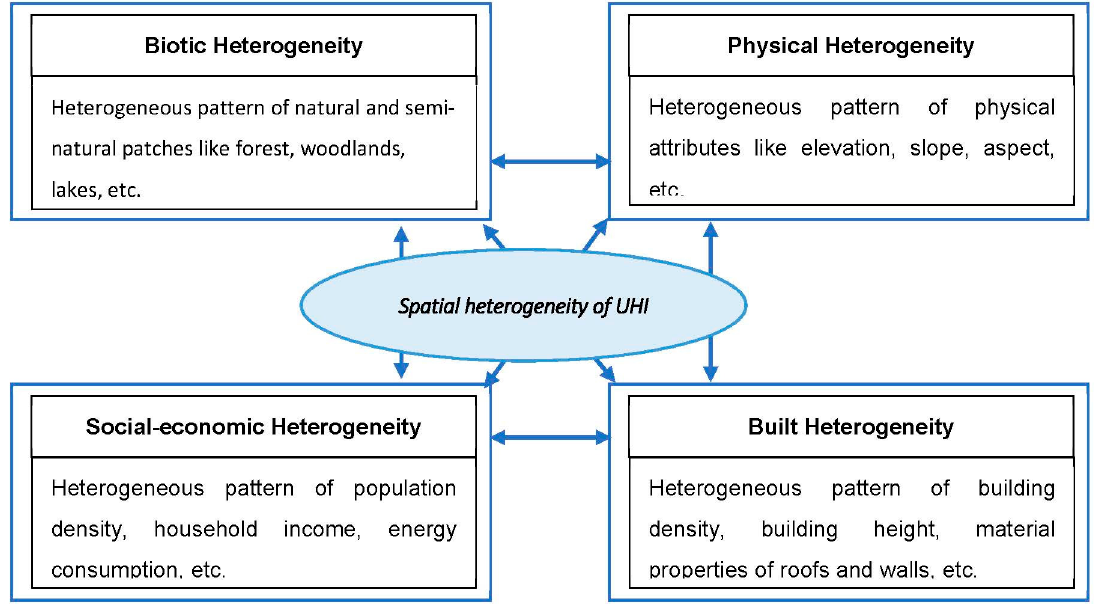
Figure 1. Four components of an urban ecosystem (adopted from Pickett et al. [46]) mediate the spatial heterogeneity of UHI. spatial heterogeneity of